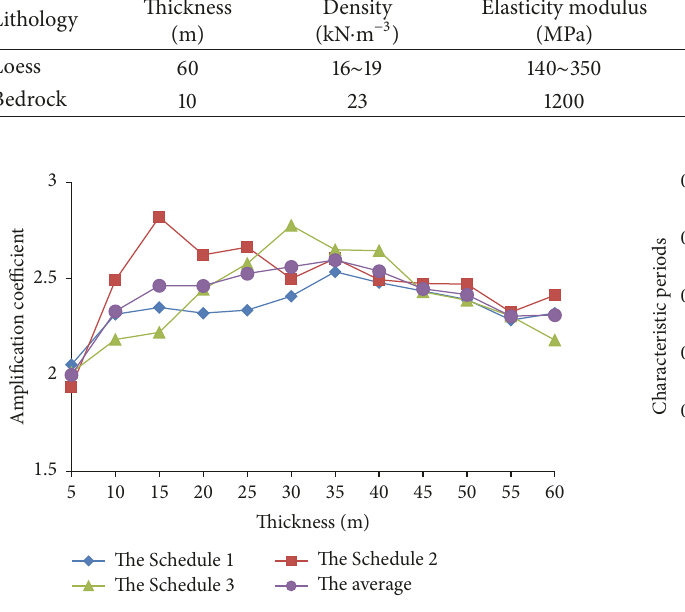
Figure 4: The distribution of the PGA amplification coefficient.